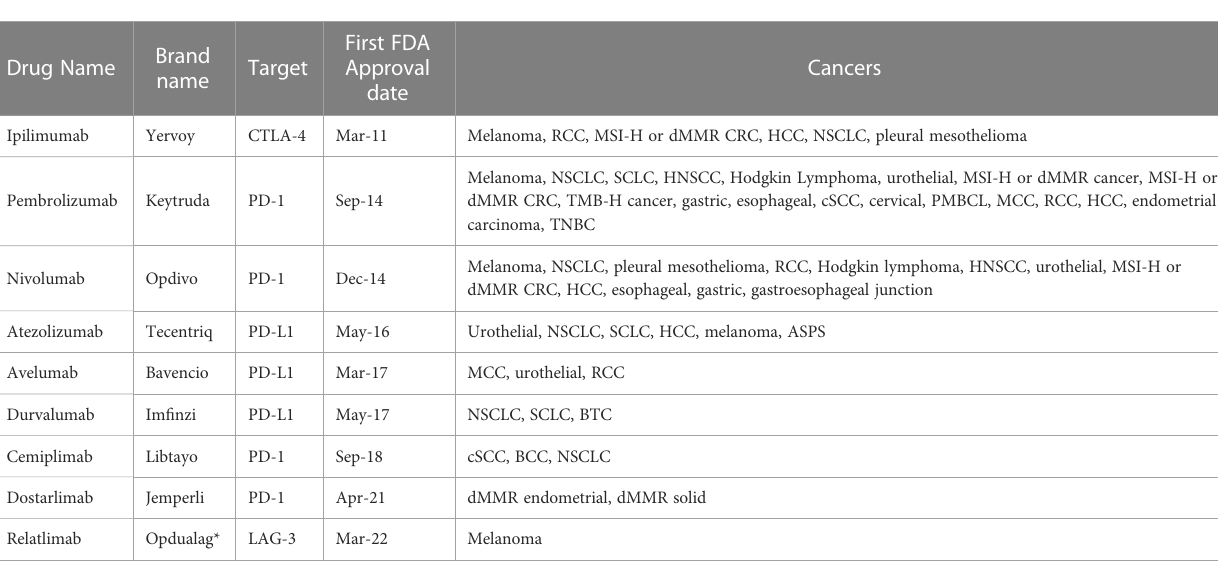
TABLE 7 FDA approved immune checkpoint